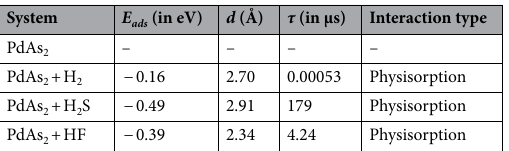
Table 1. The adsorption energy ( E ads ), adsorption distance ( d ), relaxation time ( τ ) and interaction type.